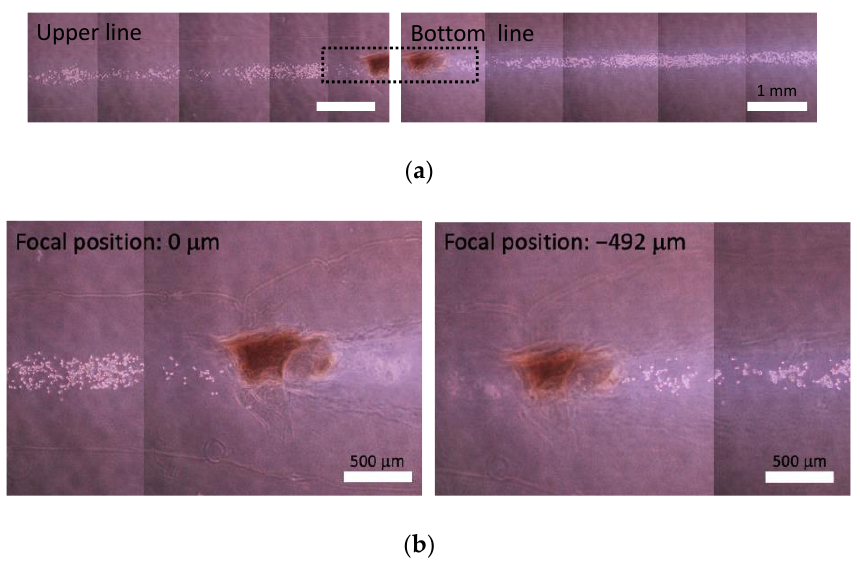
Figure 6. Phase-contrast images of straight lines at different depth in atelocollagen gel. ( a ) Gross images of upper and bottom lines, ( b ) enlarged images at different focal positions indicated by dashed line in the gross image.